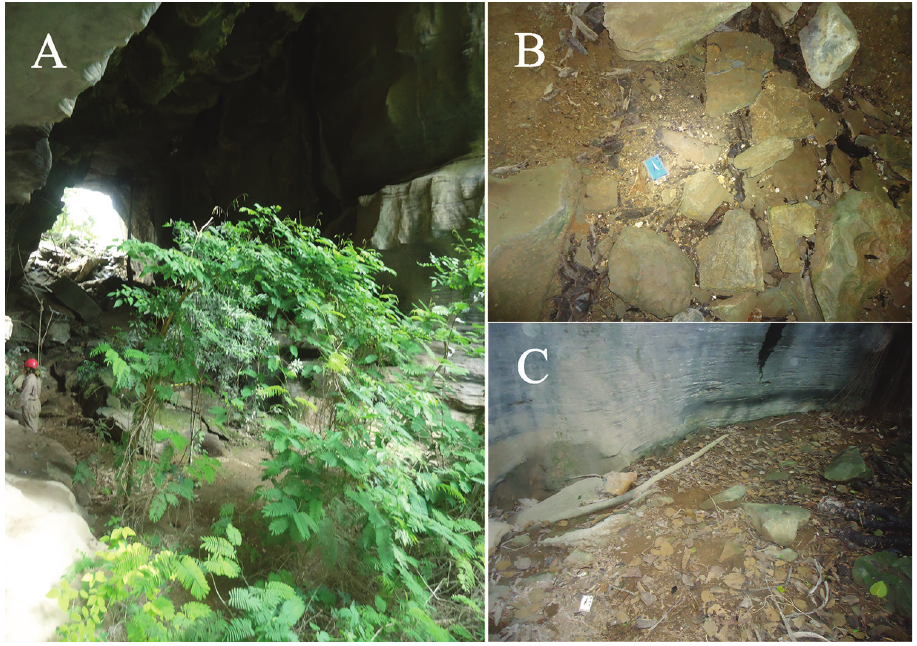
Figure 10. General aspects of the places where the specimens of Neocarus spelaion sp. n. were found: A overview of the cave B, C Substrates where the specimens were